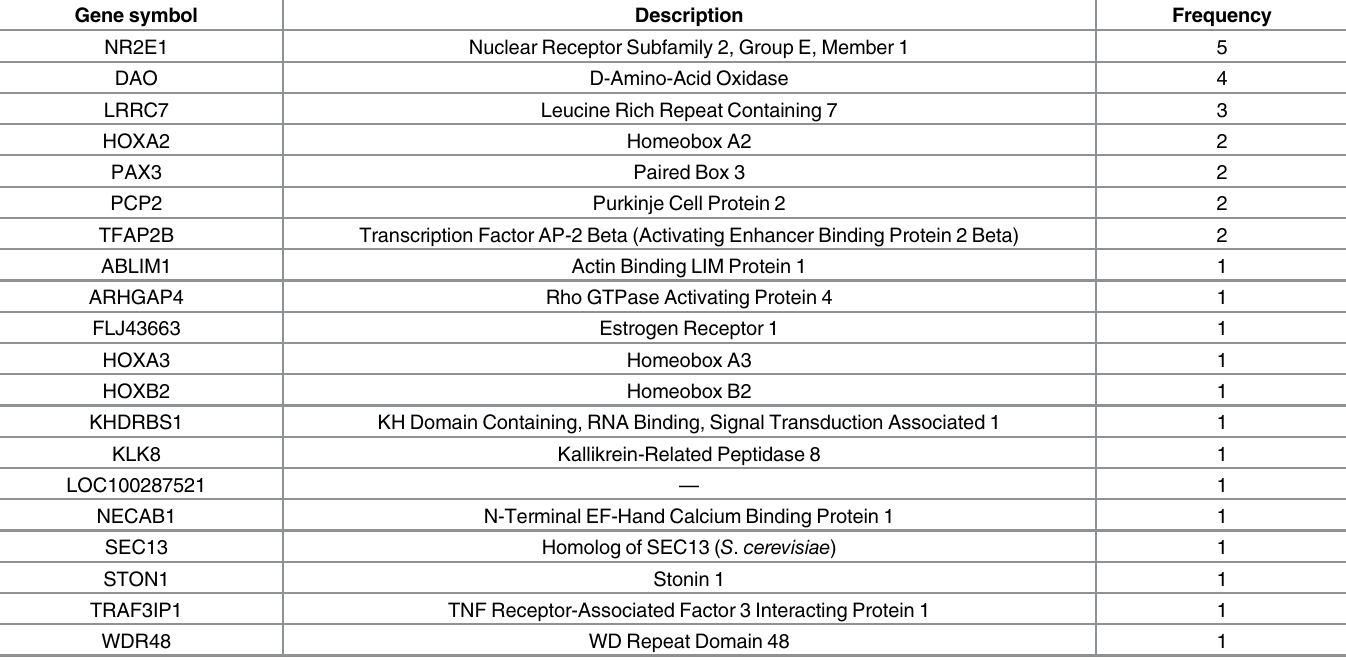
Table 2. Frequencies of the selected